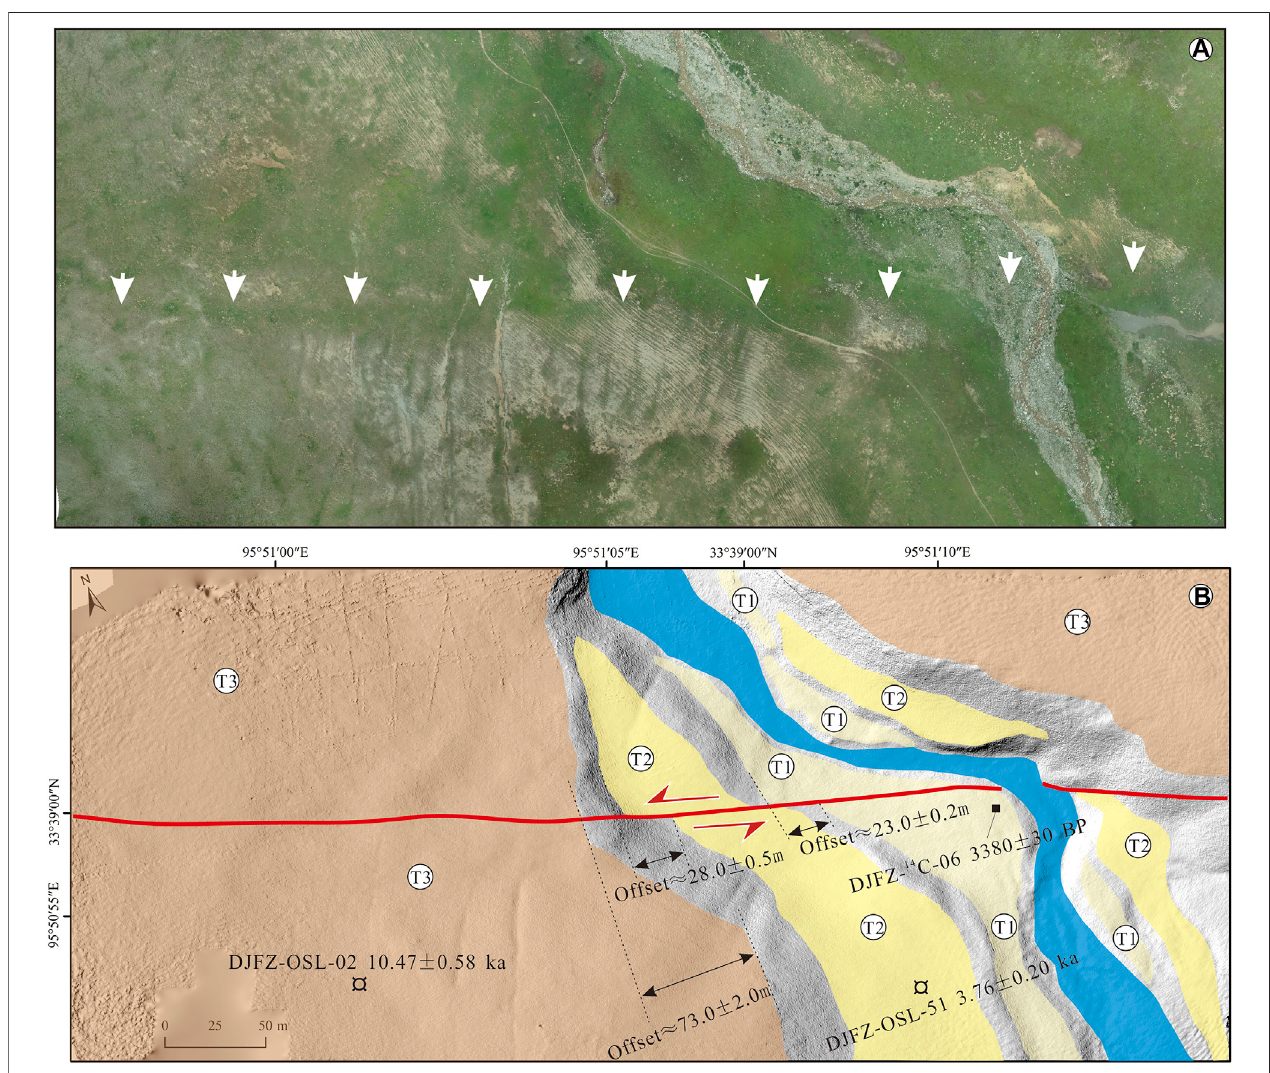
FIGURE 12 | Tectonic geomorphic features west of Riqing village along the middle section of the DJF (the study site is marked in Figure 3 M). (A) The orthophoto imagetakenfromadroneshowsthatthefaultactivitydisplacedthegullyandriverterraces,andthewhitearrowsinthemapdelineatethefaulttrace. (B) Interpretedmap and fi eld investigation hint that the horizontal displacements of terraces T1, T2, and T3 are ~23.0 ± 0.2 m, 28.0 ± 0.5 m, and 73.0 ± 2.0 m, respectively. Red lines in the map represent the surface rupture traces.